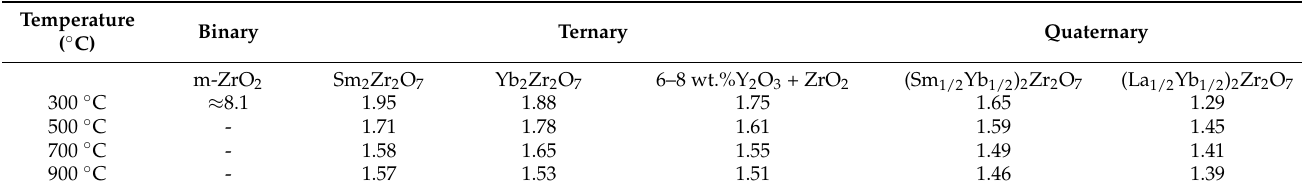
Table 1. Thermal conductively of different typical TBC